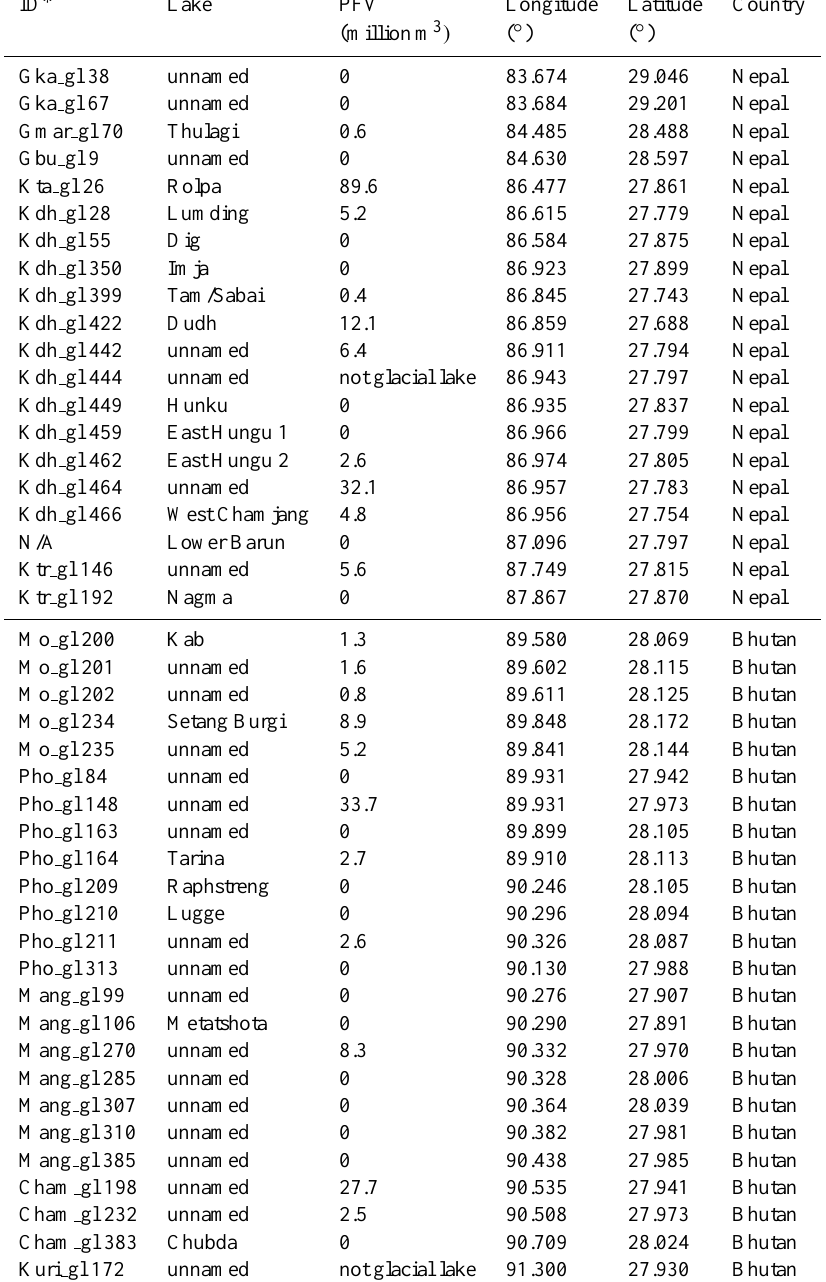
Table 2. Potential flood volume (PFV) of potentially dangerous glacial lakes identified by previous studies (Mool et al., 2001a,